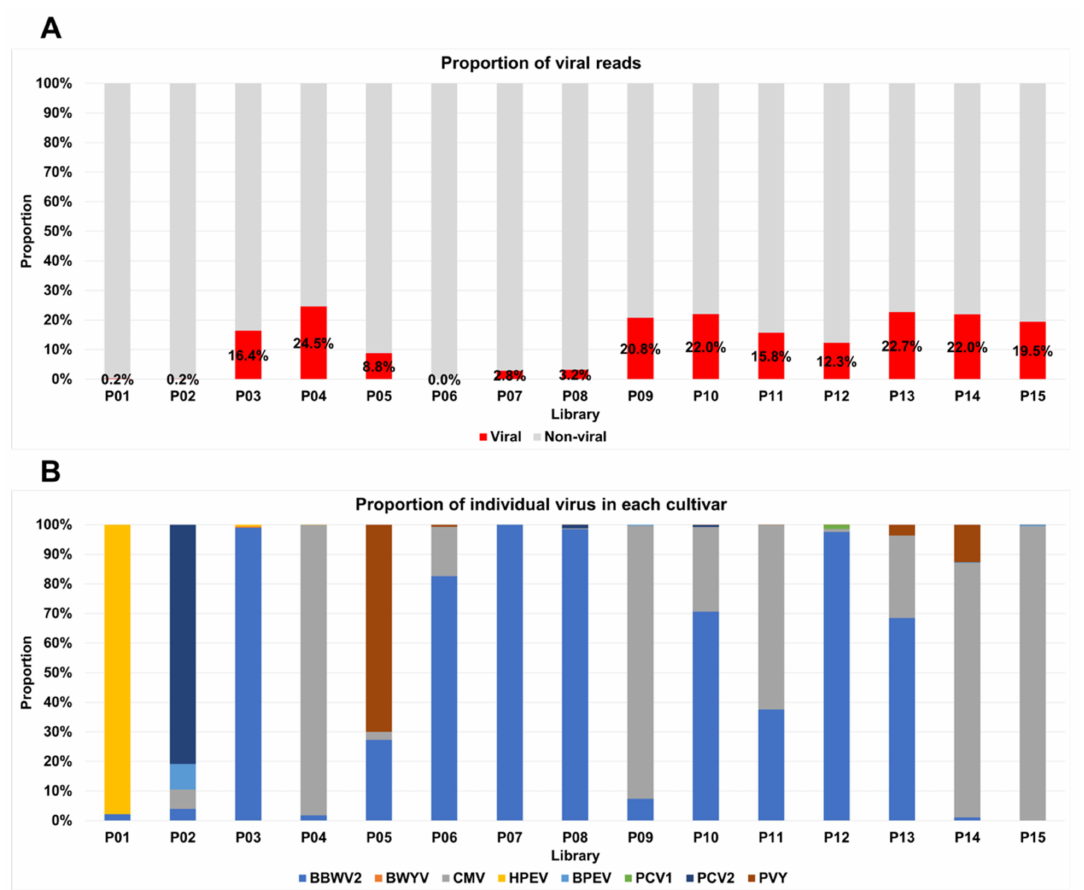
Figure 3. The proportion of viral reads in each library and the proportion of identified viruses in each library: ( A ) the proportion of viral reads (red color) as compared to non-viral reads (gray color); ( B ) the proportion of identified viruses in each library. Only viral reads assigned to the identified viruses were used for the calculation of virus proportion in each